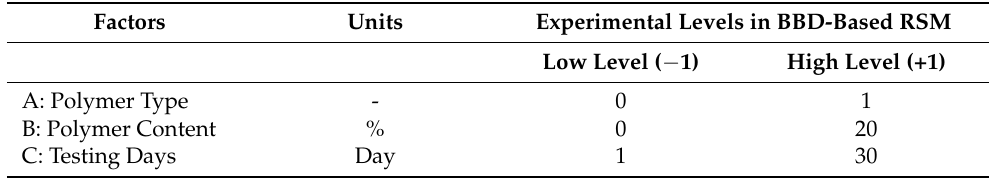
Table 2. Experimental design for Box–Behnken design (BBD)-based RSM. Factors Units